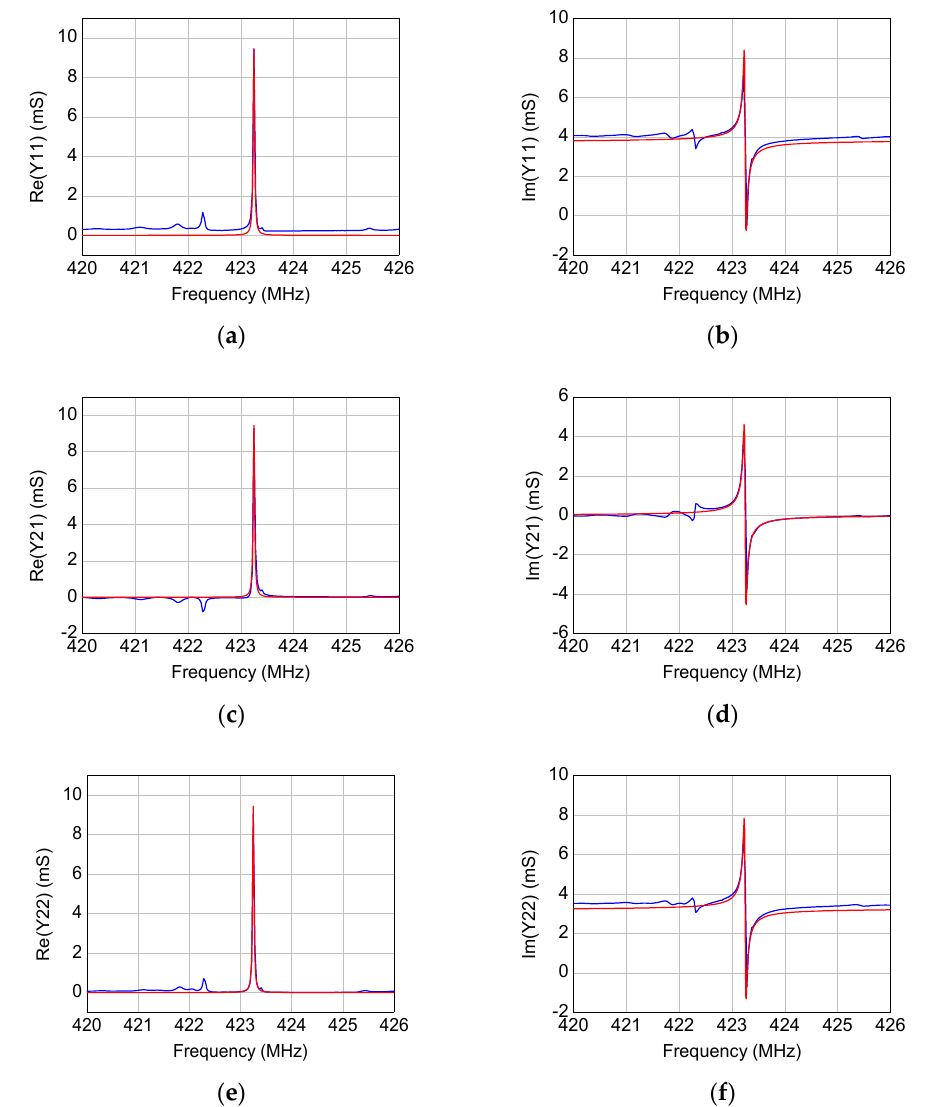
Figure 7. Comparison between (blue) measured and (red) simulated frequency-dependent behavior of ( a , b ) Y 11 , ( c , d ) Y 21 , and ( e , f ) Y 22 for the 423.22 MHz SAW resonator.